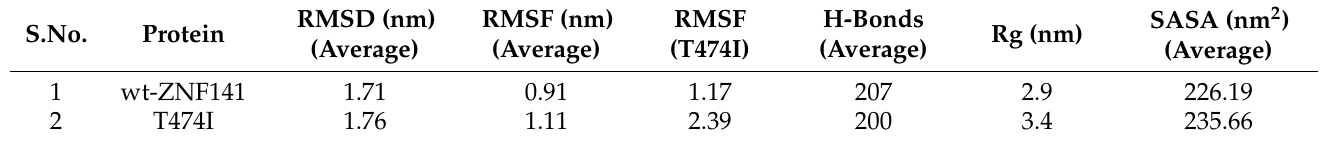
Table 1. The calculated parameters for all the systems were obtained after 100-ns MD